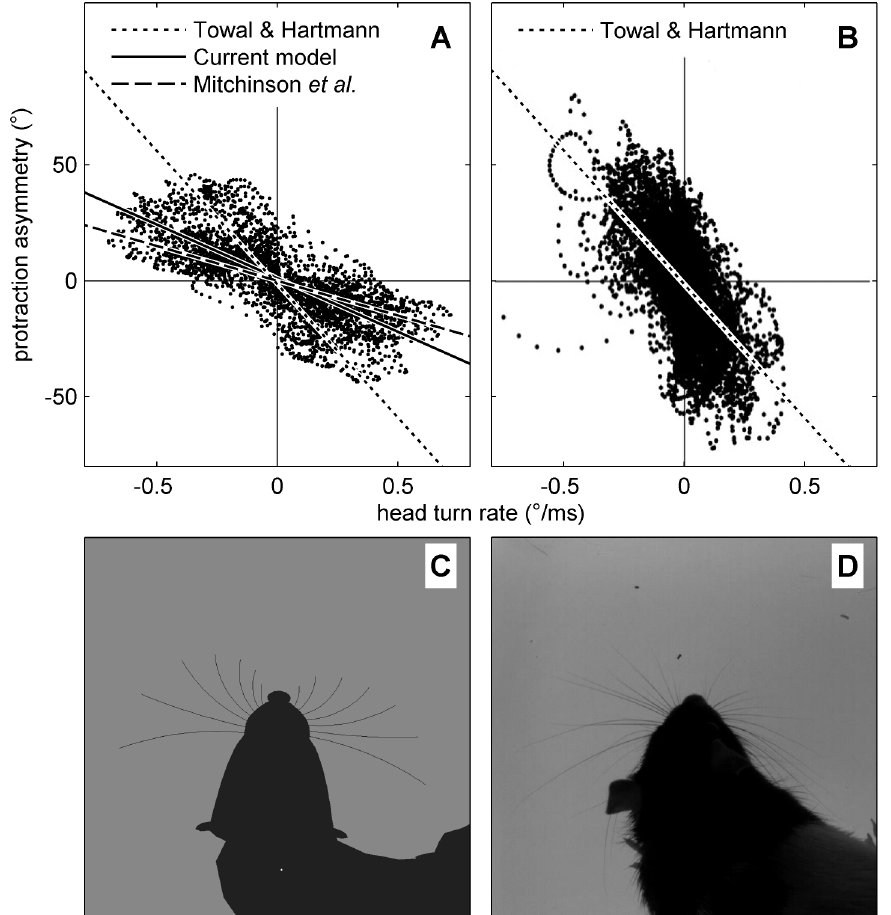
Figure 6. Head-turning asymmetry. (A) Results from model. Each dot represents one sample; solid line is line of best fit. Also shown are lines of best fit from analogous observations made by Towal & Hartmann (2006) [19] (dotted line, their Figure 6a) and Mitchinson et al. (2011) [15] (dashed line, their Figure 4a(i)). Note, therefore, that results from simulated model fall between results from two behavioural studies. (B) Results from Towal’s & Hartmann’s behavioural experiment [19], reproduced with permission. (C/D) Stills from model (C) and behavioural experiment (D) showing asymmetry in bilateral protraction angles during head turn to the right. Still in (C) is taken from Video S5.